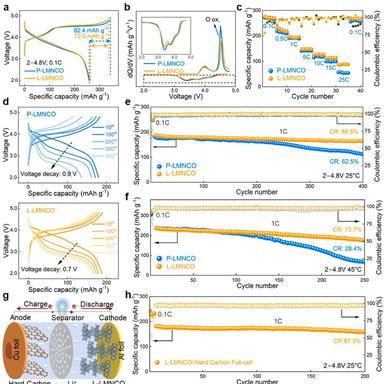
Electrochemical performances of P-LMNCO and L-LMNCO cathodes. (a,b) Initial charge-discharge curves and dQ/dV curves at 0.1C in the voltage range of 2.0–4.8 V; (c) rate performance at different current densities; (d) several characteristics charge-discharge curves at different cycles and (e,f) long-term cycle of P-LMNCO and L-LMNCO cathode with Li-metal anode at 1C under 25 ◦C and 45 ◦C, respectively; (g,h) schematic diagram of LMNCO||HC full cell and the cycle performance of L-LMNCO||HC cell at 1C.